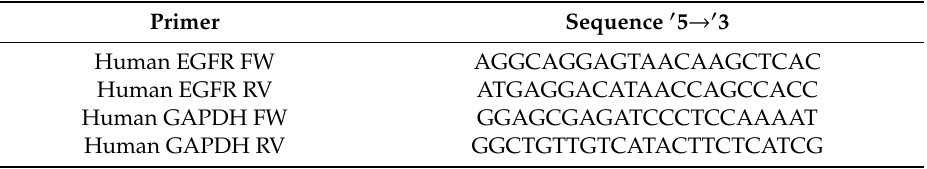
Table 1. Primer sequences used for quantitative Polymerase Chain